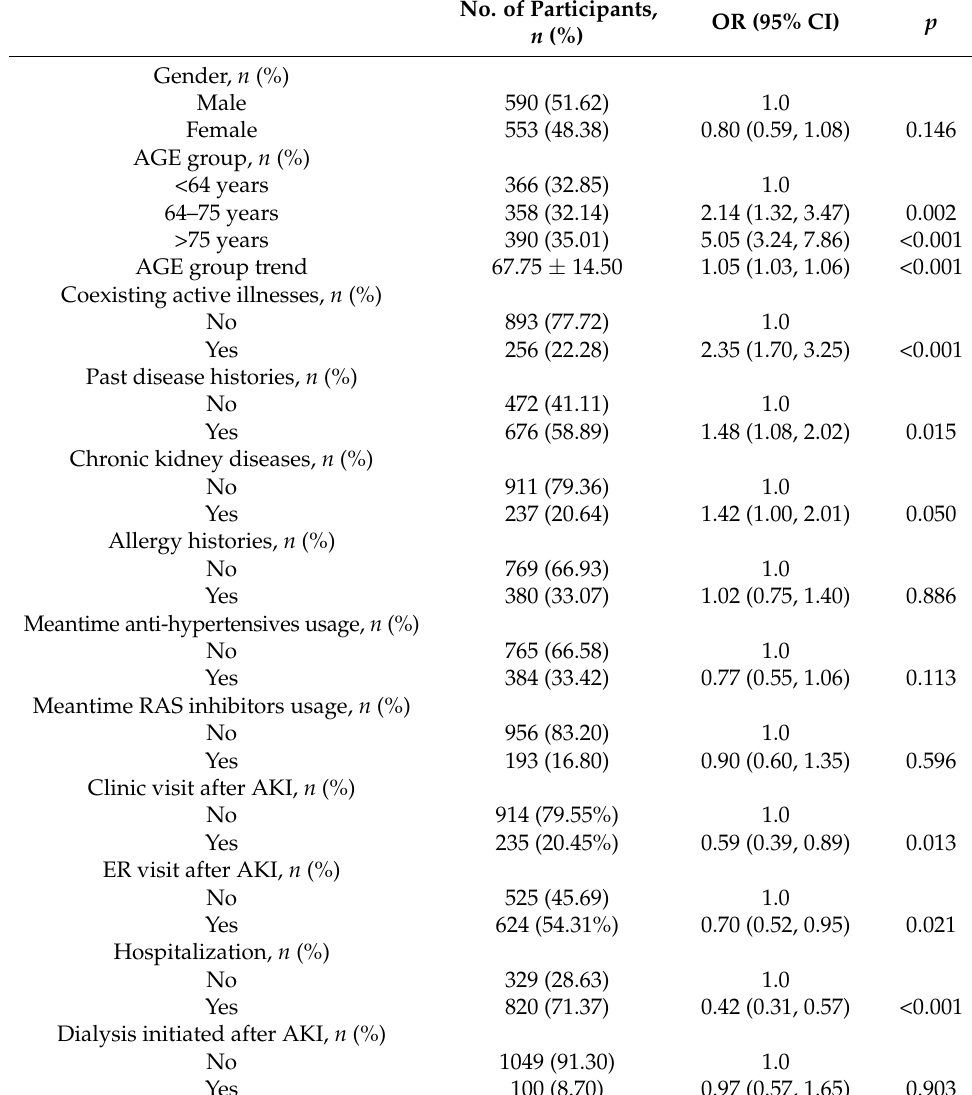
Table 2. Univariate analysis for deceased AKI patients after COVID-19